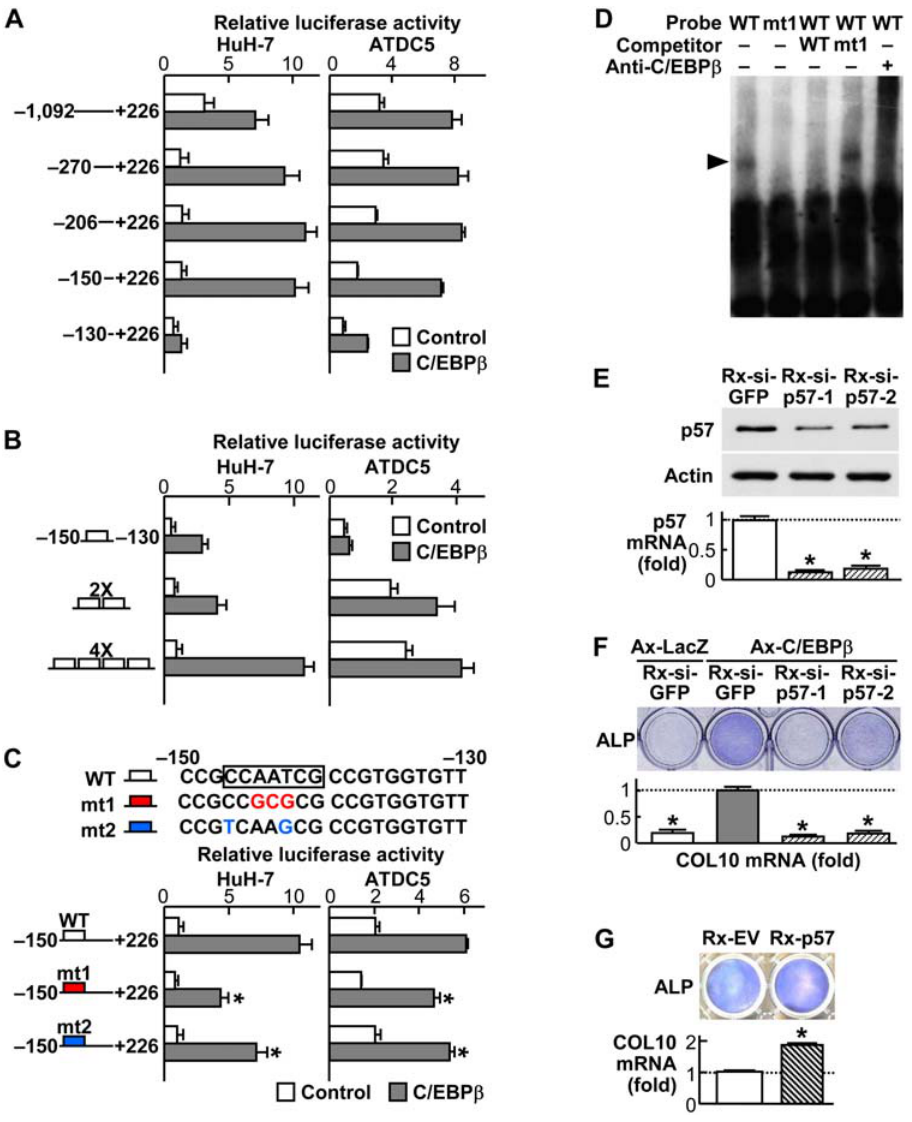
Figure 5. C/EBP b transactivates p57 through binding to a C/EBP motif and the C/EBP b -p57 signal induces chondrocyte hypertrophic differentiation. (A) Deletion analysis using luciferase-reporter constructs containing the 5 9 -flanking sequences from 2 1,092 to + 226 bp of the p57 promoter and a series of deletion fragments in HuH-7 and ATDC5 cells transfected with C/EBP b or the control GFP. (B) Dose-response analysis of the tandem repeats of the identified responsive element ( 2 150/ 2 130) by the luciferase-reporter assay in the HuH-7 and ATDC5 cells. (C) Site-directed mutagenesis analysis by two mutations (mt1 and mt2) in the C/EBP b motif ( 2 147/ 2 141) as compared to the wild-type (WT) construct by the luciferase-reporter assay in HuH-7 and ATDC5 cells. *P , 0.01 vs. WT-C/EBP b . (D) EMSA for specific binding of the nuclear extract from C/EBP b - transfected ATDC5 cells with the oligonucleotide probe ( 2 160/ 2 120) containing the WT or mt1 C/EBP b motif. The arrowhead indicates the complex. Cold competition with 50-fold excess of unlabeled WT or mt1 probe, and supershift by an antibody to C/EBP b of the complex are also presented. (E) The protein and mRNA levels of p57 determined by immunoblotting and real-time RT-PCR, respectively, by the p57 siRNA. Stable lines of C3H10T1/2 cells retrovirally transfected with two kinds of siRNA of p57 (Rx-si-p57-1 and Rx-si-p57-2) or the control GFP siRNA (Rx-si-GFP) were established. *P , 0.01 vs. Rx-si-GFP. (F) Effects of the p57 siRNA above on the C/EBP b -induced hypertrophic differentiation of chondrocytes. Primary rib chondrocytes were transfected with Rx-si-p57-1, Rx-si-p57-2, or Rx-si-GFP, and further adenovirally co-transfected with C/EBP b or the control LacZ (Ax-C/EBP b or Ax-LacZ). Hypertrophic differentiation was determined by ALP staining and relative COL10 mRNA level by real-time RT-PCR analysis at 2 weeks of culture after confluency. *P , 0.01 vs. Ax-C/EBP b with Rx-si-GFP. (G) Hypertrophic differentiation of ATDC5 cells stably transfected with the retrovirus expressing p57 (Rx-p57) or the empty vector (Rx-EV) cultured for 3 weeks with insulin and further for 2 d with inorganic phosphate. *P , 0.01 vs. Rx-EV. All graphs are expressed as means (bars) 6 SEM (error bars) for 6